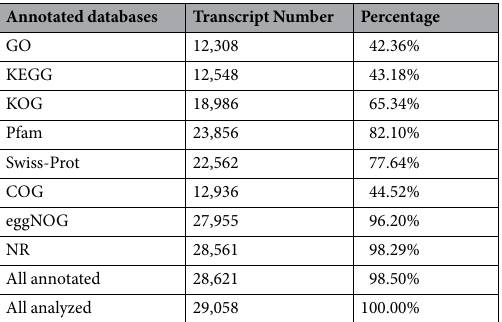
Table 4. Annotation of transcripts using public databases. GO, Gene Ontology; KEGG, Kyoto Encyclopedia of Genes and Genomes; KOG, euKaryotic Ortholog Groups; Pfam, Protein family; Swiss-Prot, a well-annotated and manually checked protein database; COG, (Clusters of Orthologous Groups; eggNOG, a database of orthologous groups and functional annotation; NR, a NCBI non-redundant protein